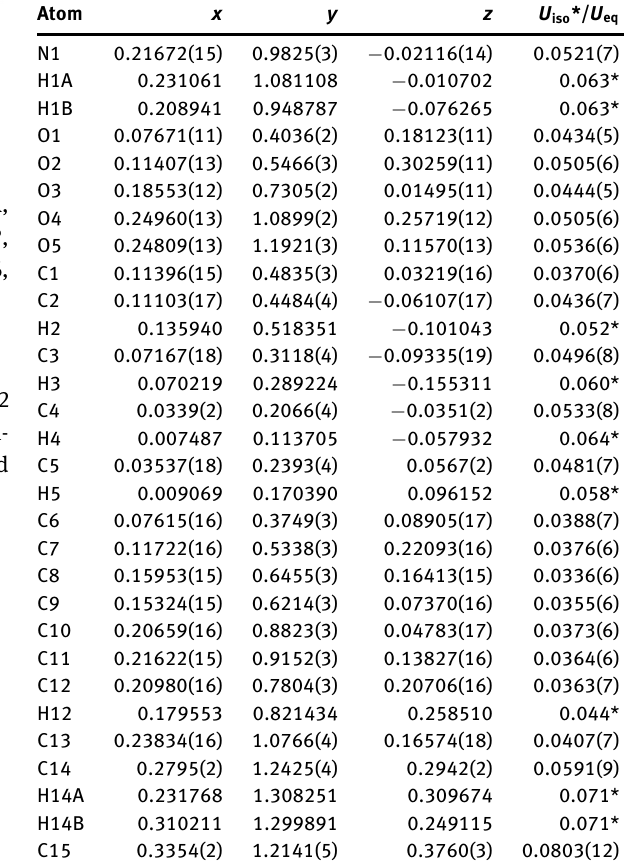
Table 2: Fractional atomic coordinates and isotropic or equivalent isotropic displacement parameters (Å 2